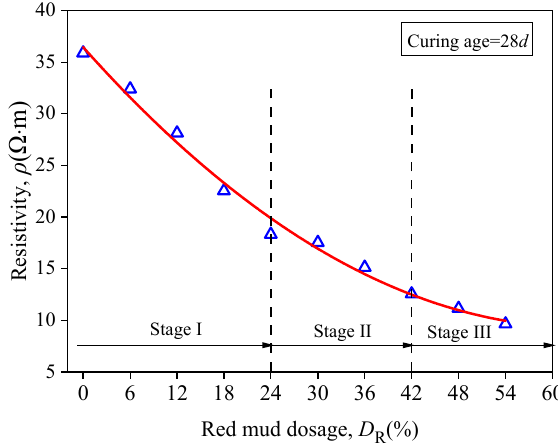
Figure 13. Relationship between resistivity and red mud dosage.